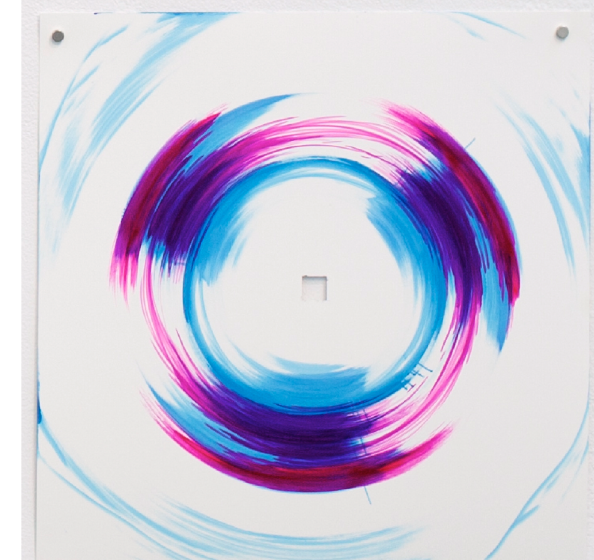
Figure 10 | Ventilator Drawing Nr. 8.